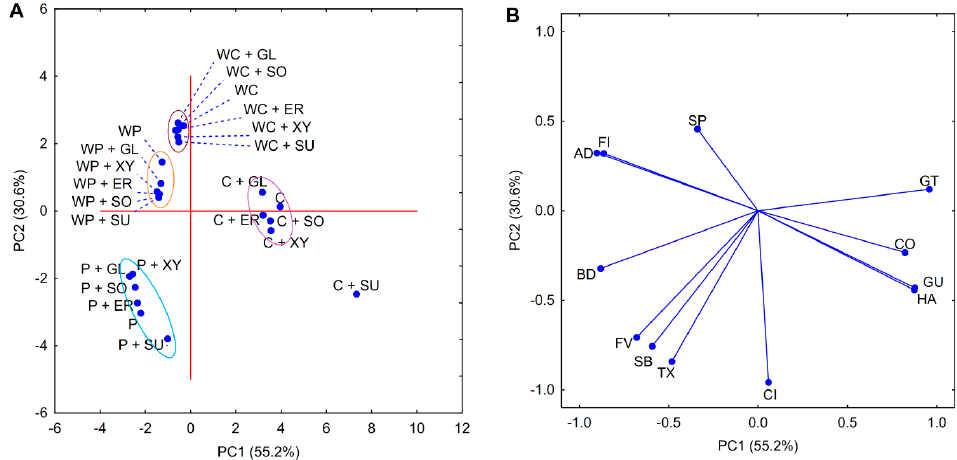
Figure 5. PCA score ( A ); loadings plot ( B ); rheological and texture properties of binary mixtures